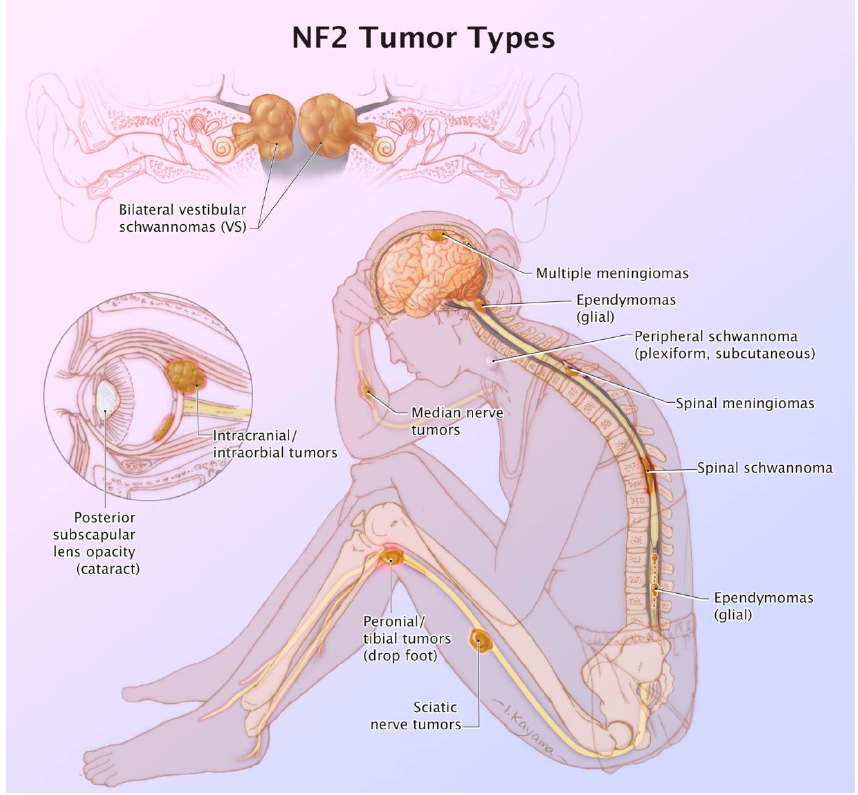
Figure 4. Summary figure of the various morbidities associated with NF2. An original illustration by Ikumi Kayama.